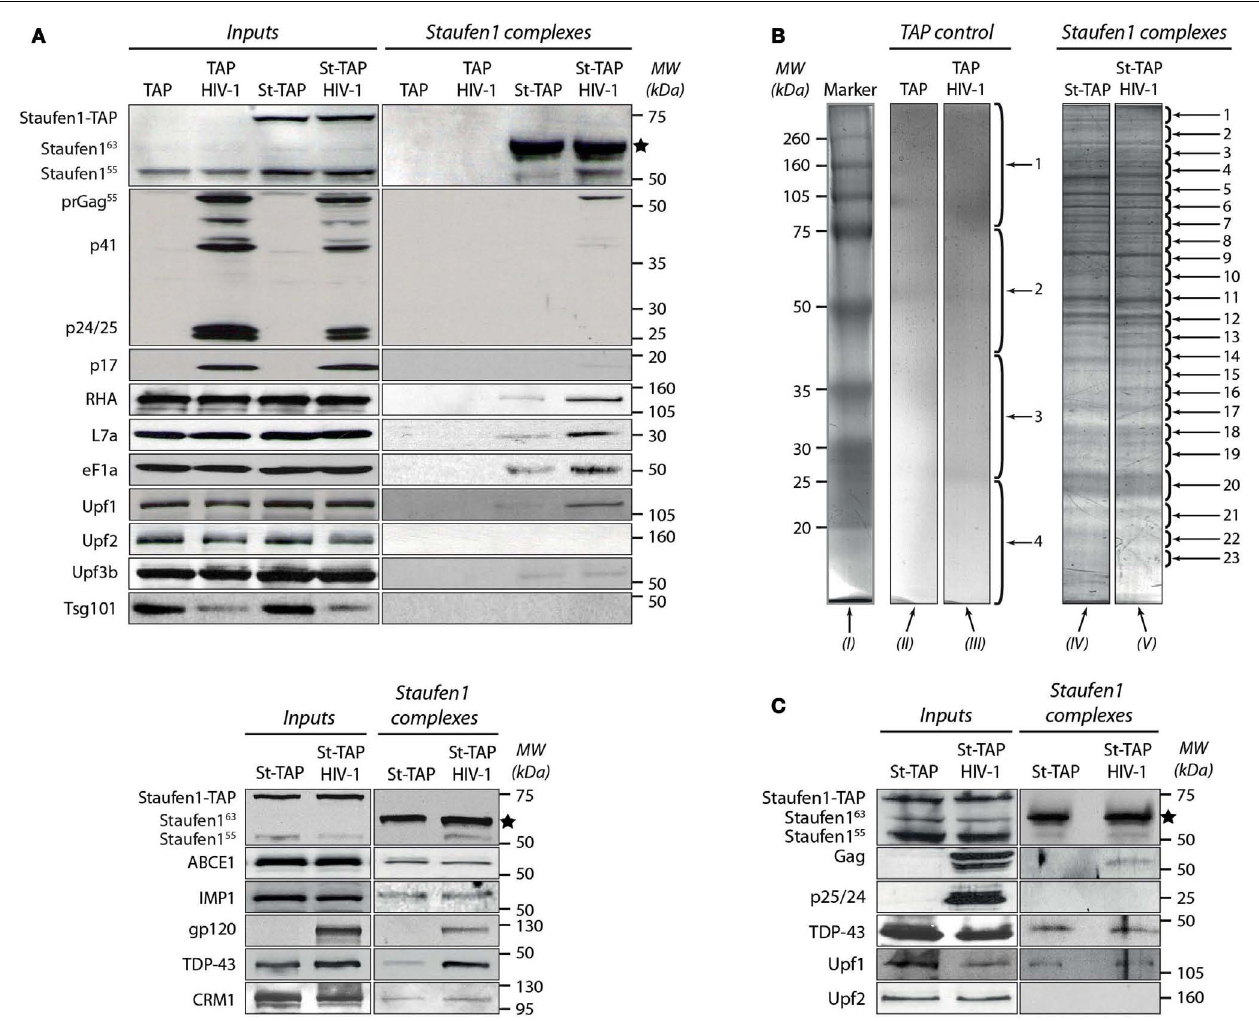
Staufen1 55kDa complexes and those fromTAP alone (control) were purified from 75mg of total protein, separated on SDS-PAGE and subsequently stained with Bio-Safe Coomassie Blue. Four bands were excised from gel lanes (II) and (III) for the identification of potential contaminating proteins. 23 bands from St-TAP and St-TAP HIV-1 (lanes IV and V) were excised and analyzed with mass spectrometry. Lane I represents the molecular weights in kDa of the protein standards. (C) Dual affinity purification of Staufen1 complexes derived from JurkatT St-TAP stable cell lines in the absence or in the presence of